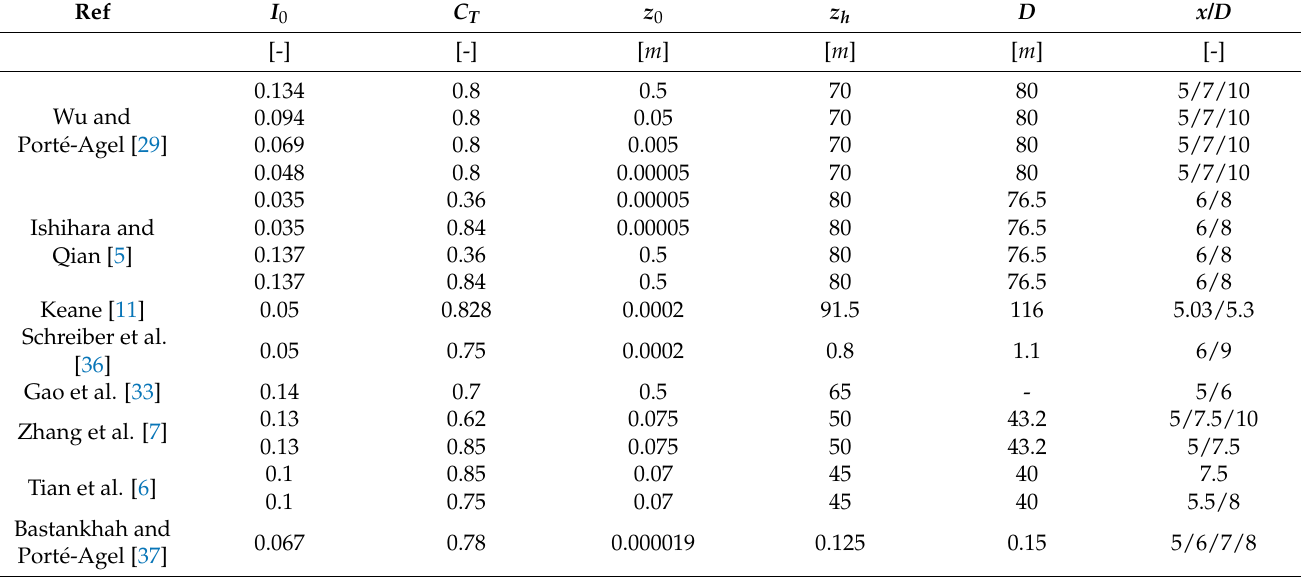
Table 7. Descriptions of basic parameters of measurements and